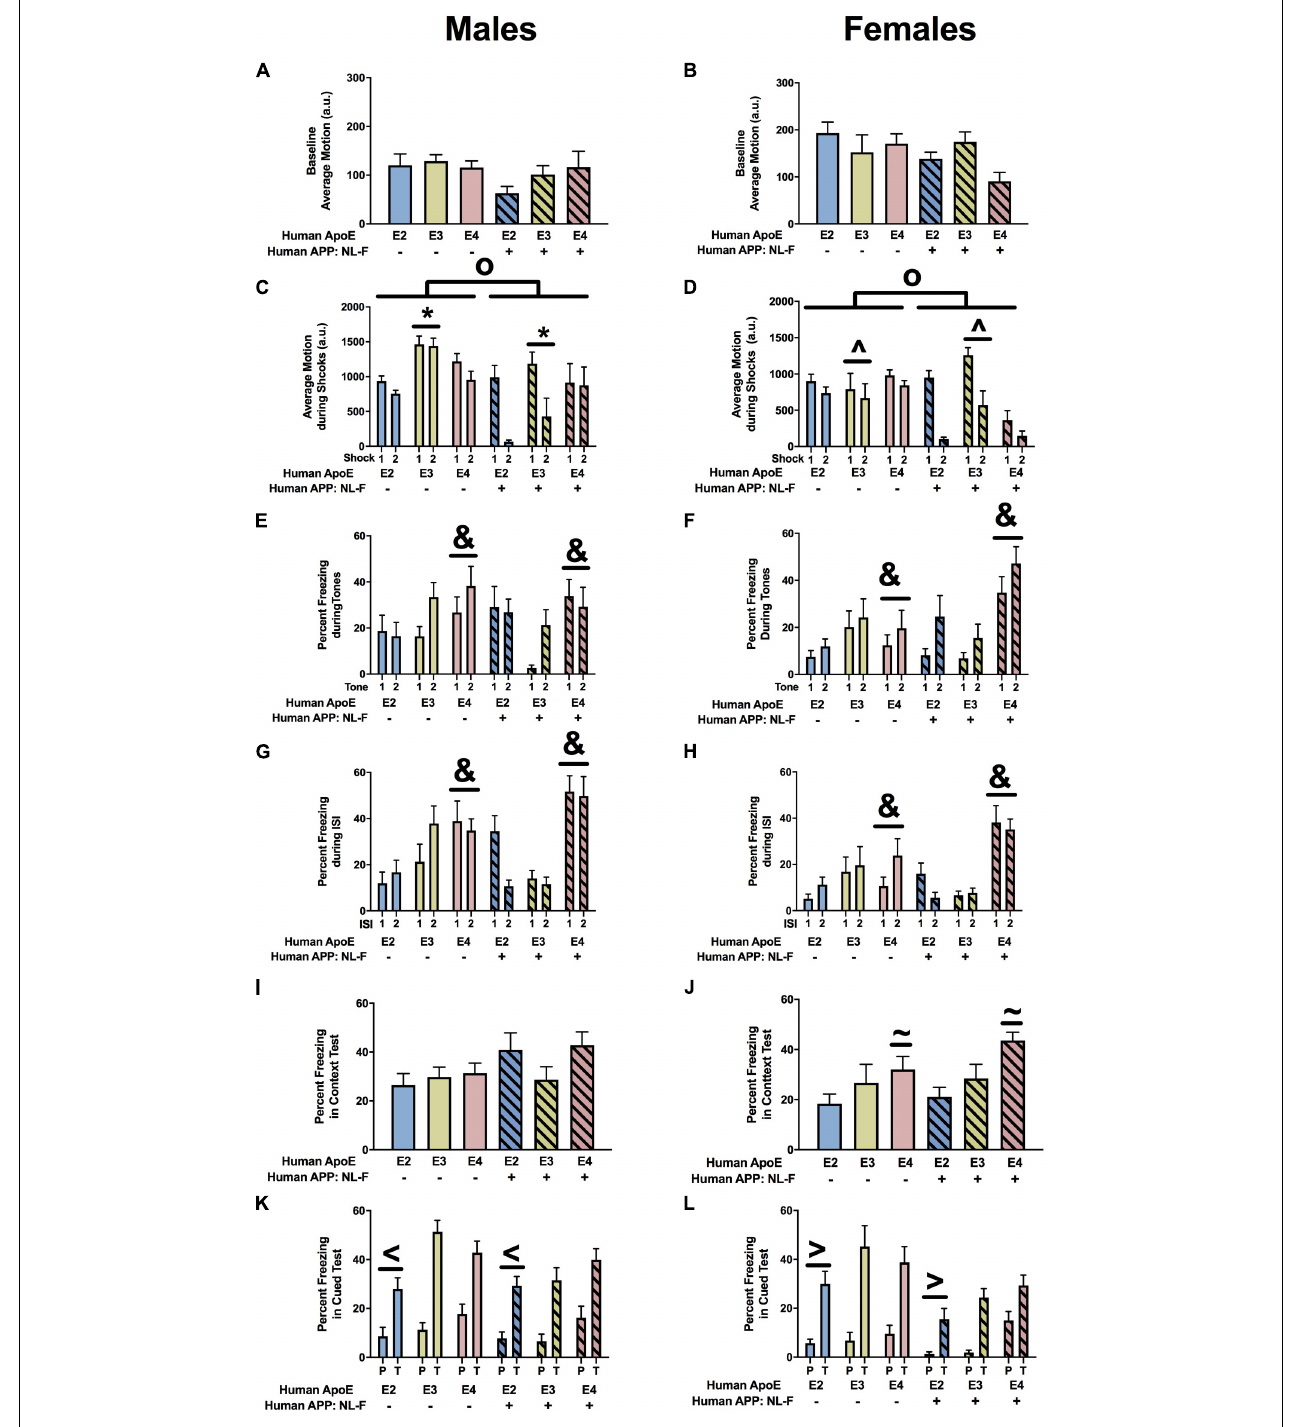
FIGURE 11 | Performance of males (A,C,E,G,I,K) and females (B,D,F,H,J,L) in the fear conditioning test at the 18-month time point. (A) Baselines motion of males in the fear conditioning test. (B) There was a trend toward an effect of APP on baseline motion of females in the fear conditioning test. NL-F females showed lower activity levels during the baseline period. (C) There was an effect of APP, APOE, and an APP × APOE interaction for average motion of males during the shocks. E3 males moved more during the shocks than E2 males. * p < 0.05. In addition, NL-F males moved less during the shocks. o p < 0.05. (D) There was an effect of APP, APOE, and an APP × APOE interaction for average motion of females during the shocks. E3 females moved more during the shocks than E4 females. ∧ p < 0.05. NL-F females also moved less during the shocks. o p < 0.05. (E) There was an effect of APOE on freezing of males during the tones. E4 males froze more during